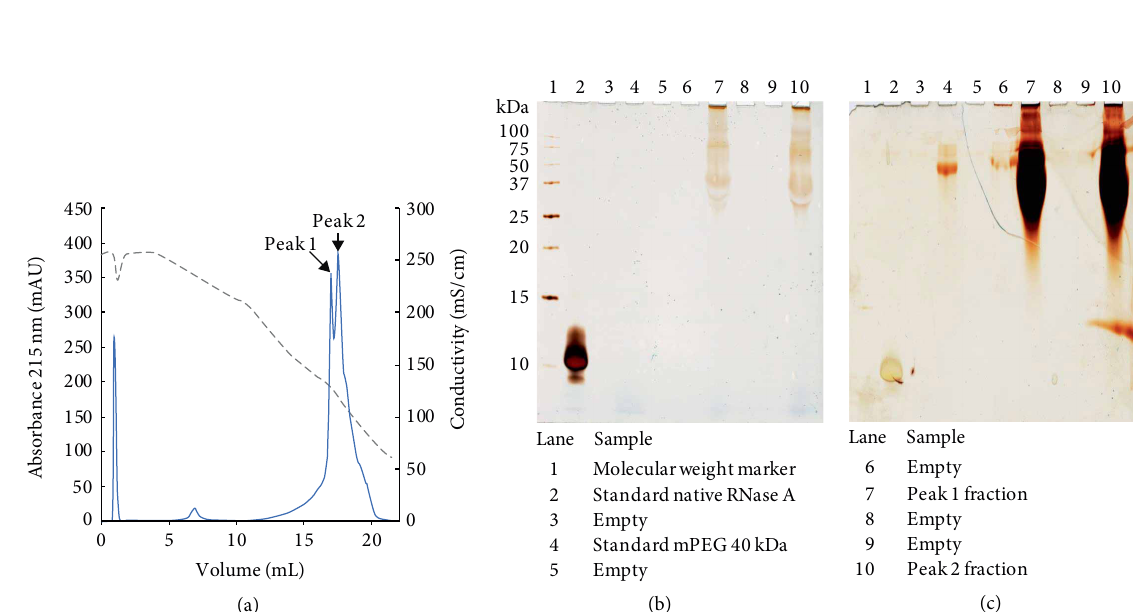
Figure 3: Separation and observation of 40.0 kDa PEGylated RNase A isomers using the 20.0 kDa PEGylated monolith. (a) Chromatogram at 215 nm of 40.0 kDa PEGylated RNase A in the 20.0 kDa PEGylated monolith using a step gradient elution. Buffer A: Tris–HCl 20.0 mM pH 8.2. Buffer B : Buffer A + 3.0 M ammonium sulphate. Loop 0.1 mL, Volumetric flow 1 mL min −1 . (b) Silver staining for protein detection of SDS–PAGE analysis of the chromatographic fractions. (c) I -BaCl staining for mPEG detection of SDS–PAGE analysis of chromatographic 2 2